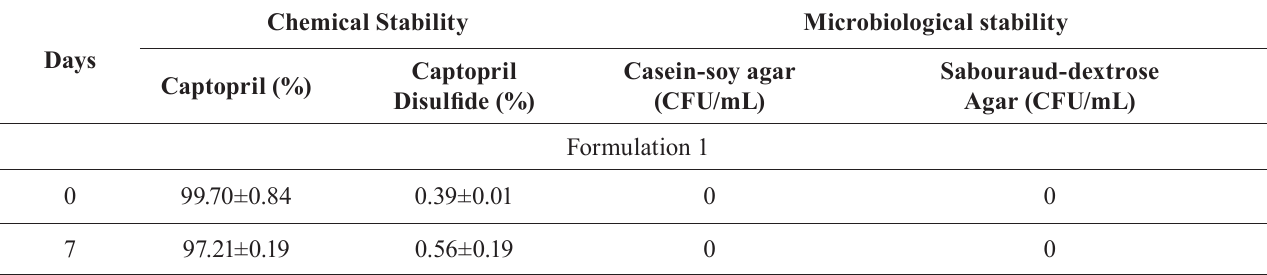
TABLE VI - Stability study of oral liquid Formulation 1 and Formulation 2 stored in refrigerator at 5oC Days